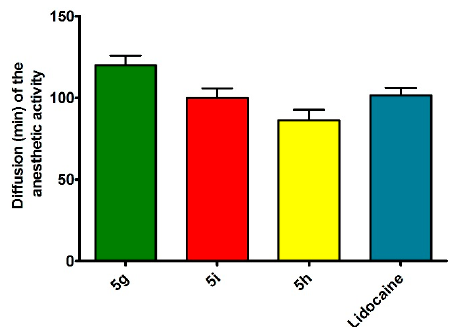
Figure 1. In vivo duration of local anesthetic activity (rat sciatic nerve block) of lidocaine and compounds 5g , 5i and 5h . Each rat received 0.2 mL of the 2% anesthetic solution. The values are means ± standard deviation of three independent experiments.